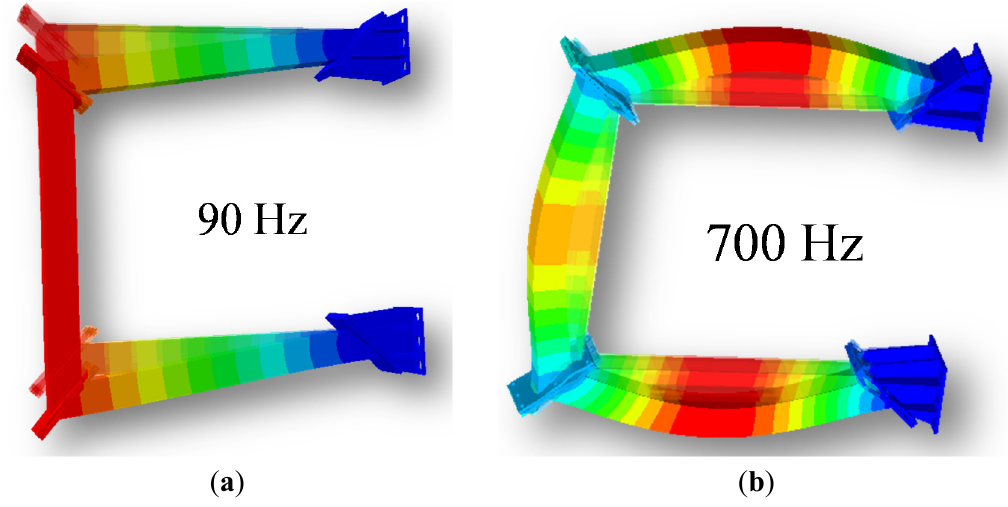
Figure 4. Dimensionless displacement vectors ( i.e. , eigenvectors) for the selected low-frequency ( a ) and high-frequency ( b ) modes of the gantry